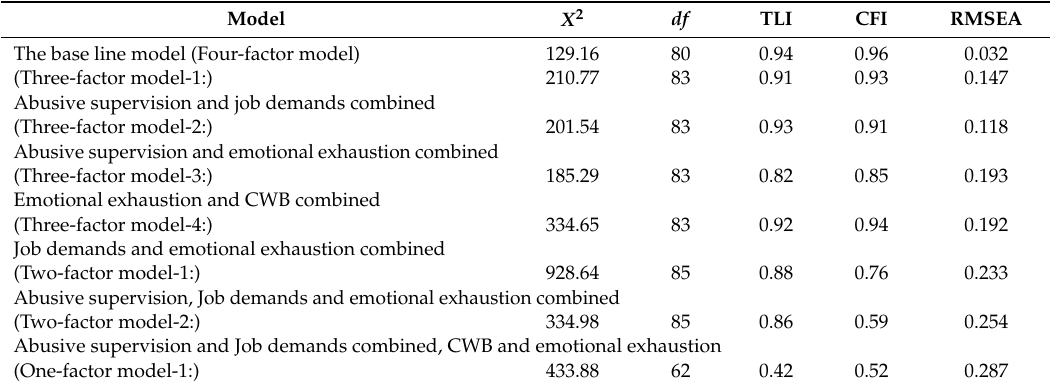
Table 1. Results of CFA for all exogenous and endogenous